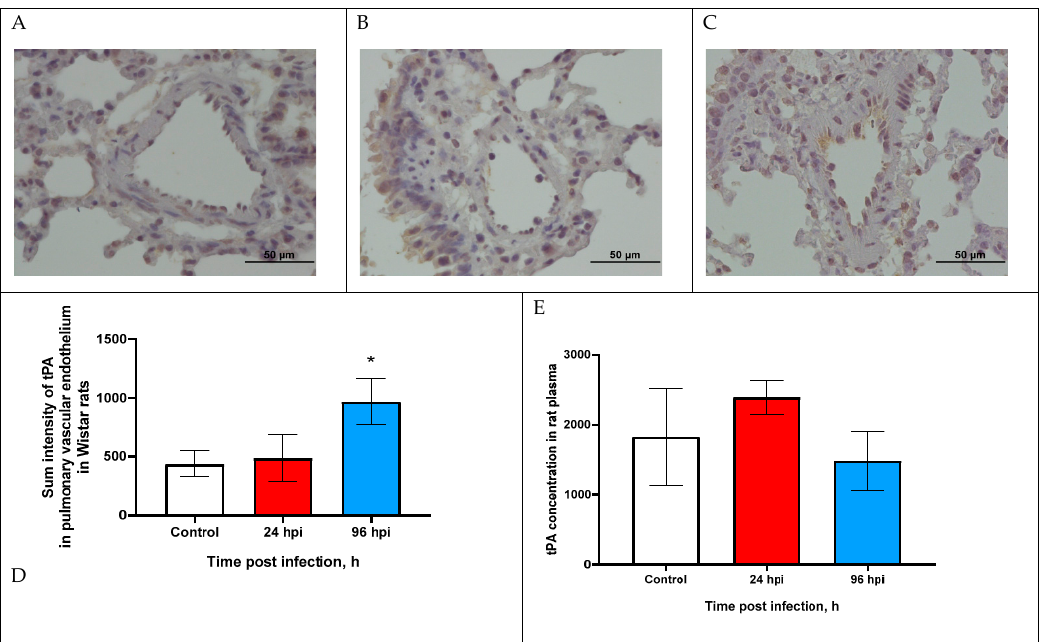
Figure 2. tPA expression in pulmonary vascular endothelium of control rats ( A ) and infected at 24 ( B ) and 96 h post infection ( C ) with influenza A(H1N1)pdm09 virus using anti-tPA murine mAbs. Magnification ×400; DAB chromogen staining. ( D ) tPA sum intensity in pulmonary vascular en- dothelium of rats infected with influenza A(H1N1)pdm09 virus. Values represent mean ± standard deviation from 30 blood vessels of 10 rats in every group. * p < 0.05 versus control group (Krus- kal–Wallis test). ( E ) tPA concentration in blood plasma of infected rats infected with influenza A(H1N1)pdm09 virus. Values represent mean ± standard deviation from 10 rats in every group. * p < 0.05 versus control group (Mann–Whitney test).